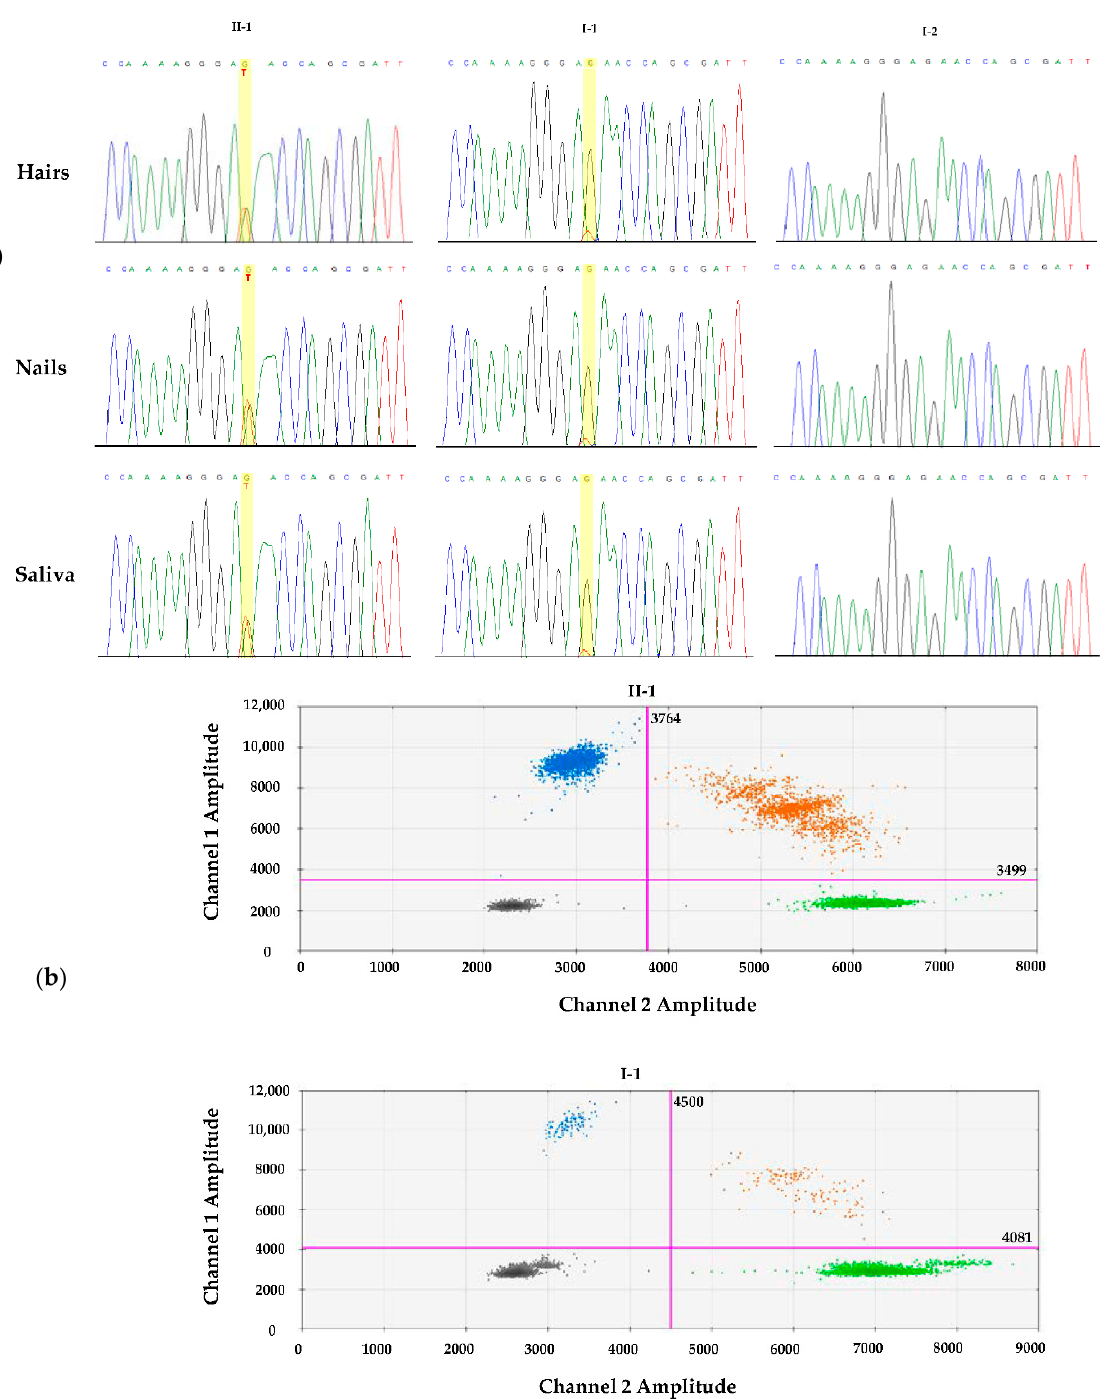
Figure 2. COL5A1 c.1369G>T mosaicism among different tissues, and quantification of the mutant frequency alleles in the blood samples. ( a ) Electropherograms showing Sanger sequencing of COL5A1 exon 9 harboring the c.1369G>T, p.(Glu457*) variant in the hairs, nail bulbs and saliva of the proband, her father and a healthy individual. ( b ) The ddPCR analysis output shows two-dimensional scatter plots in which Channel 1 fluorescence (FAM) is plotted against Channel 2 fluorescence (HEX) for each droplet. The droplet populations are indicated as follows: double-negative (grey), FAM-positive (blue), HEX-positive (green) and double-positive (brown = positive for FAM and HEX in the same droplet).